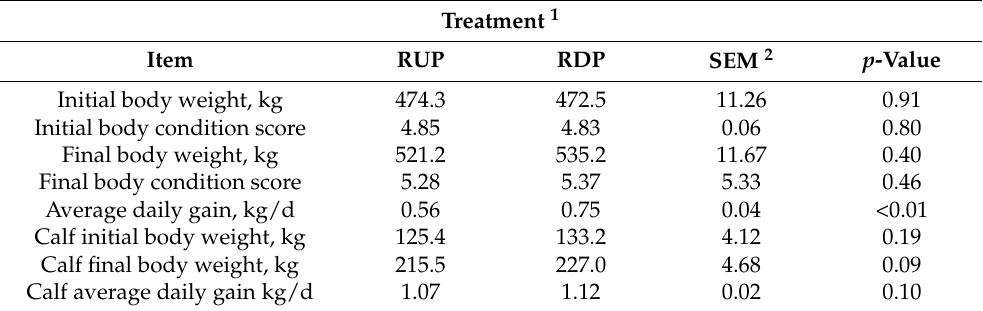
Table 7. Performance parameters of cows supplemented with rumen undegradable or degradable protein while grazing improved dryland pastures and the